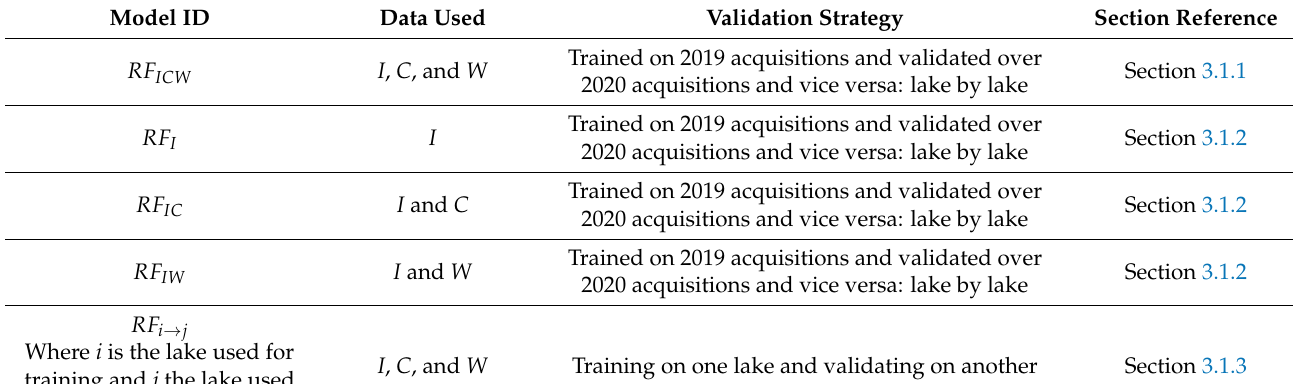
Table 3. Summary of the models and input variables that are tested in this